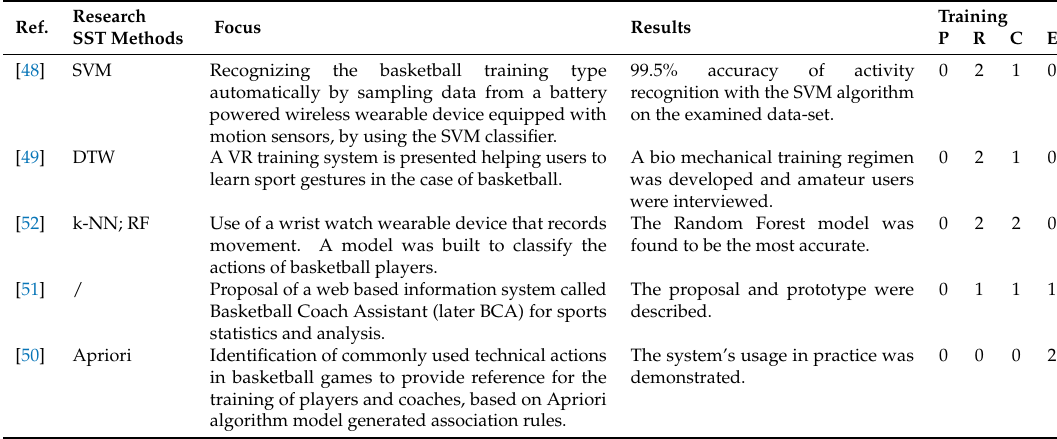
Table 5. Identified studies in the domain of basketball.